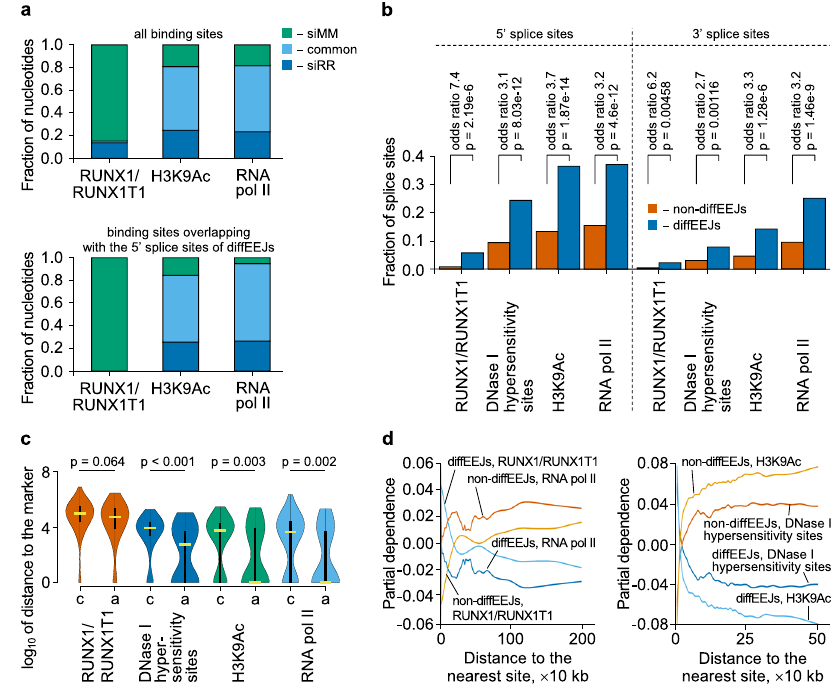
Fig. 4 RUNX1/RUNX1T1 -dependent differential splicing events in Kasumi-1 cells are associated with open chromatin. a Column graph showing the distribution of RUNX1/RUNX1T1, H3K9Ac and RNA pol II occupied sites with or without RUNX1/RUNX1T1 knockdown. The top panel shows the distribution for all sites, the bottom panel only shows distribution of binding sites overlapping with the 5 ’ splice sites of diffEEJs. b Association of diffEEJs splice sites with open chromatin. P -values were calculated with Fisher ’ s two-sided exact test. c Violin graph depicting the positional relationships between canonical (c; n = 117) and alternative (a; n = 57) 5 ’ splice sites of diffEEJs and marks of open chromatin. P -values were calculated with two-sided Mann – Whitney U test. Yellow horizontal thick lines represent the median of distances distribution, the black vertical rectangular boxes show the interquartile range, and the black vertical lines are the 95% con fi dential interval. d Effect of the proximity to RUNX1/RUNX1T1 binding sites, RNA pol II peaks, H3K9Ac histone modi fi cations and DNase I hypersensitivity sites on the probability of the diffEEJs and non-diffEEJs in the transcriptome of leukemia